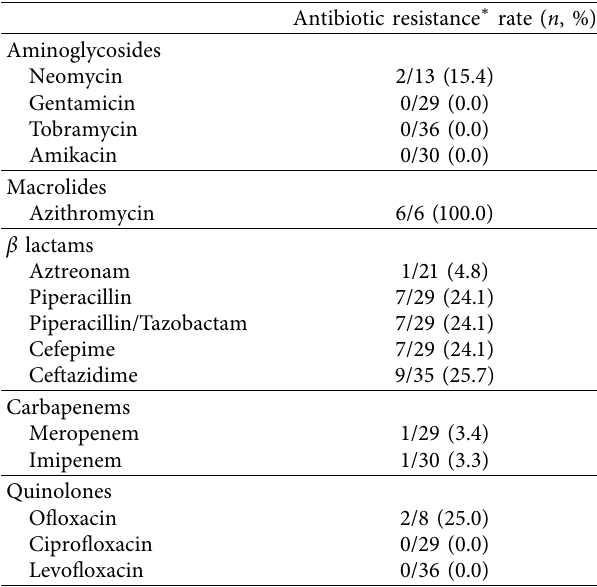
Table 3: Antibacterial resistance of cultured Pseudomonas aeruginosa